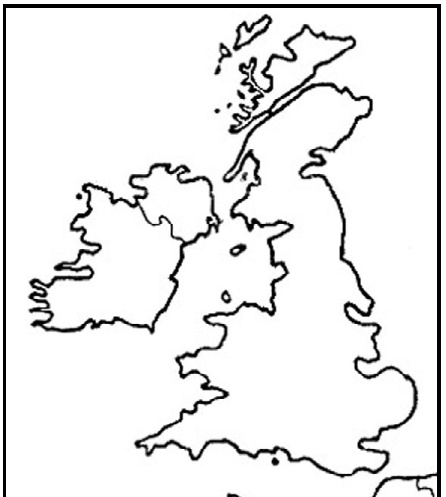
Fig 3. A map intended for the well-sighted people